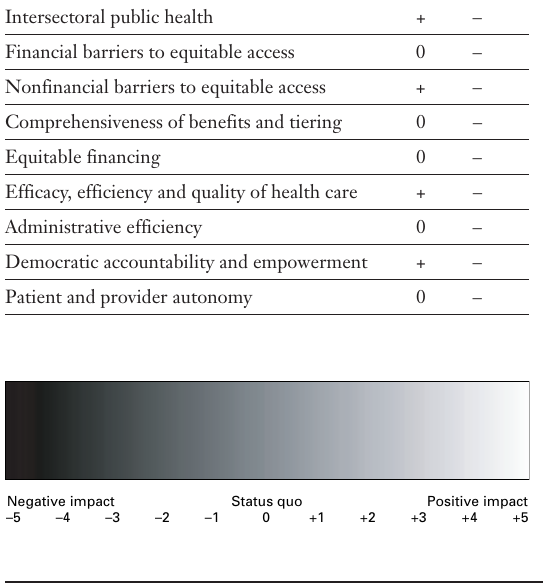
The domains of the nine “benchmarks of fairness”.